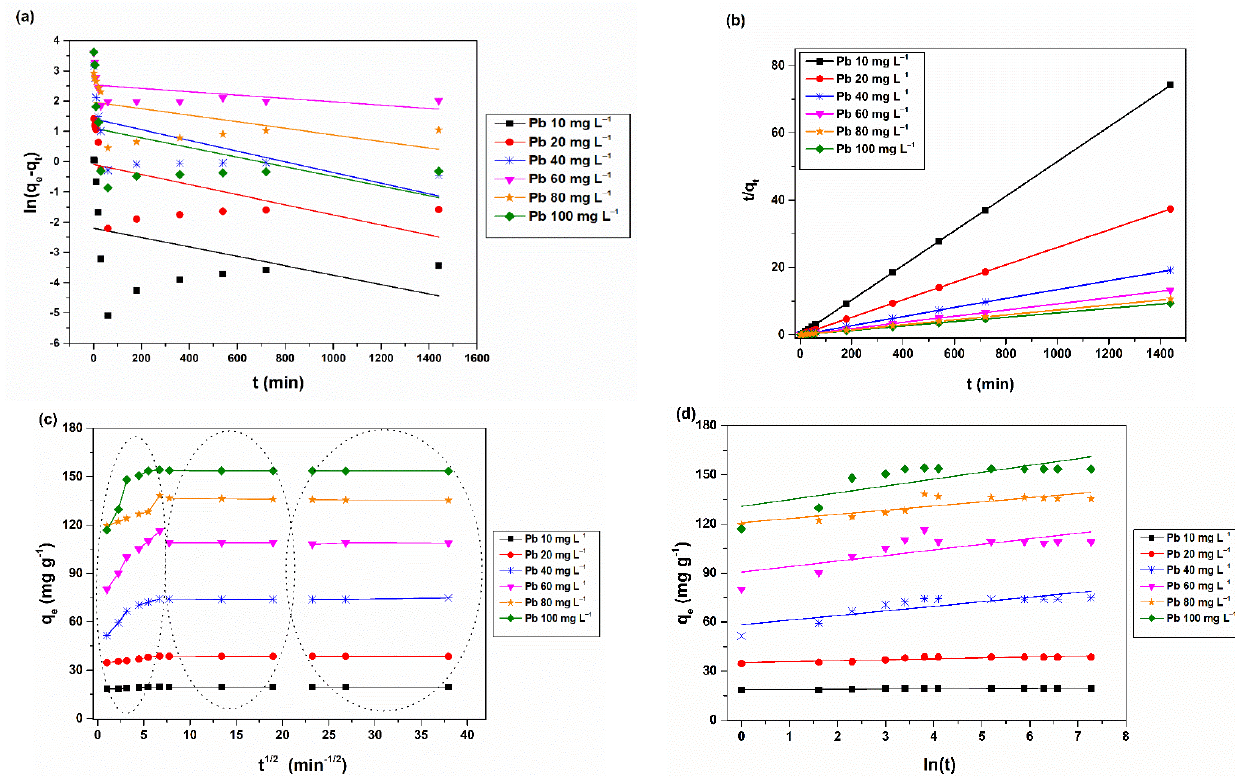
Figure 12. ( a ) Pseudo-first order, ( b ) pseudo-second order, ( c ) Weber–Morris intra-particle diffusion, and ( d ) Elovich kinetic models used to describe Pb adsorption on CHIT-PAAA.